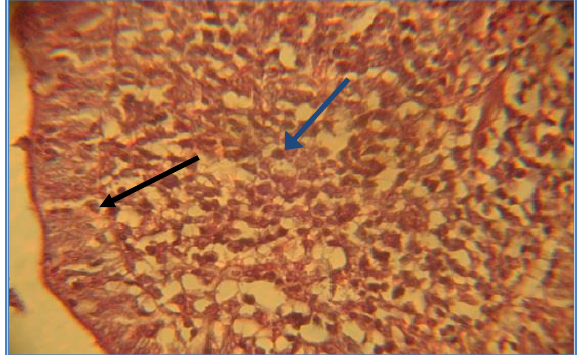
Figure, 9: Intestine of 3rd group (control positive) after 240hrs. heat exposure showed( )marked mononuclear cell infiltration in the sub epithelial layer and around mucosa gland which showed of epithelial lining cell and marked cellularity of hyperplasia Lamina propria ( ) ( H and E stain, 400X).